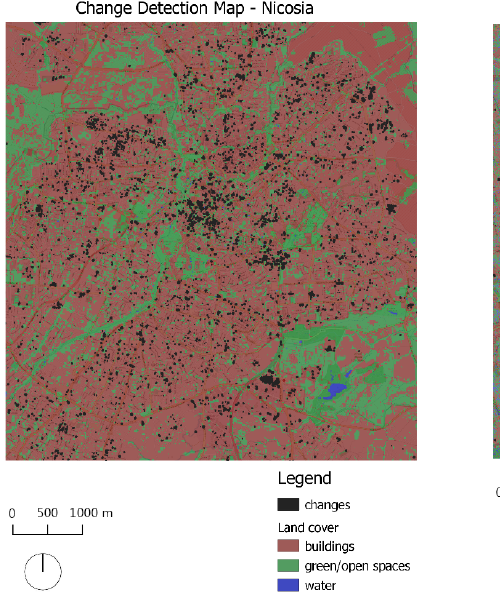
( b ) Figure 12. Changes tracked in optical images visualized on Google Earth: ( a ) Limassol; ( b ) Nicosia. Subsequently, output data were transferred from SNAP into the QGIS environment as a GeoTIFF file for post-processing to generate valuable urban change detection maps. Open Street Map was used as the base map for the representative visualisation of the re- sults. The vectorisation of the raster data was considered necessary to overlay the changed parts with the corresponding classified images. As a result, the changes were then catego- rised, and areas of the built environment that changed the most over the past six years were highlighted. Figure 13 shows a change detection map of Nicosia and Limassol pro- duced by SAR data, and combined with the classification results. Figure 14 illustrates the changes generated by optical data in both cities. As indicated in both Nicosia and Limassol, the areas with noticeable differences in